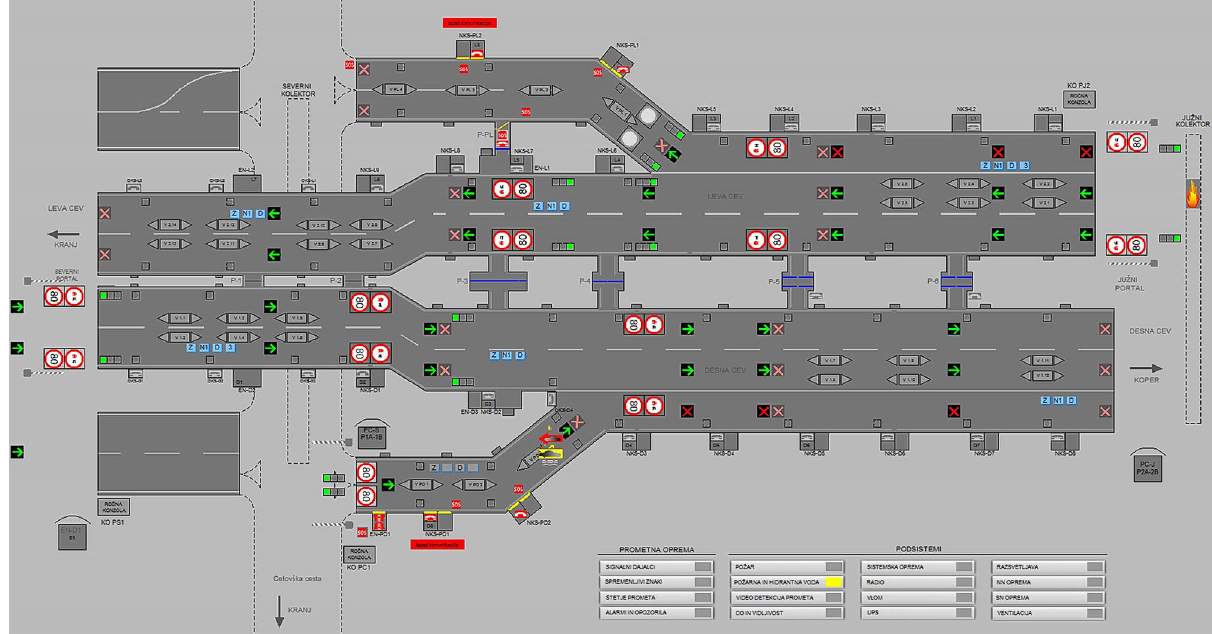
Figure 11. Operator SCADA interface